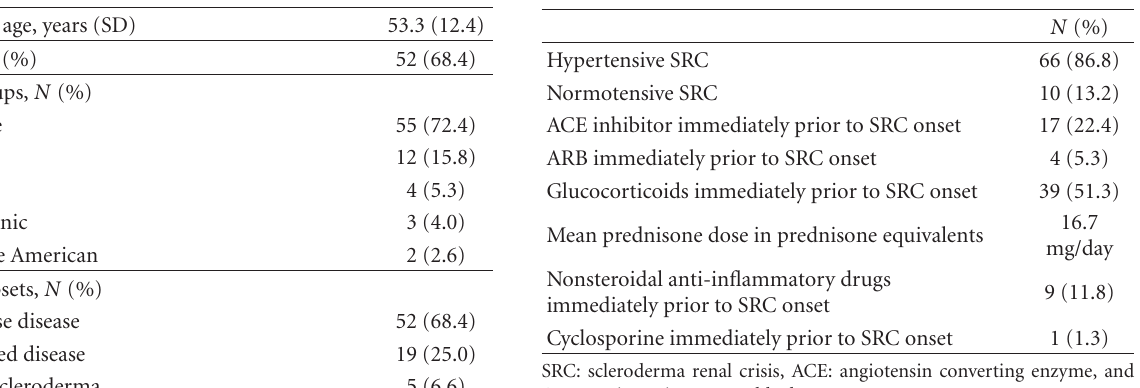
Table 1: Baseline characteristics of cohort ( N = 76). Table 2: Characteristics of study patients ( N =